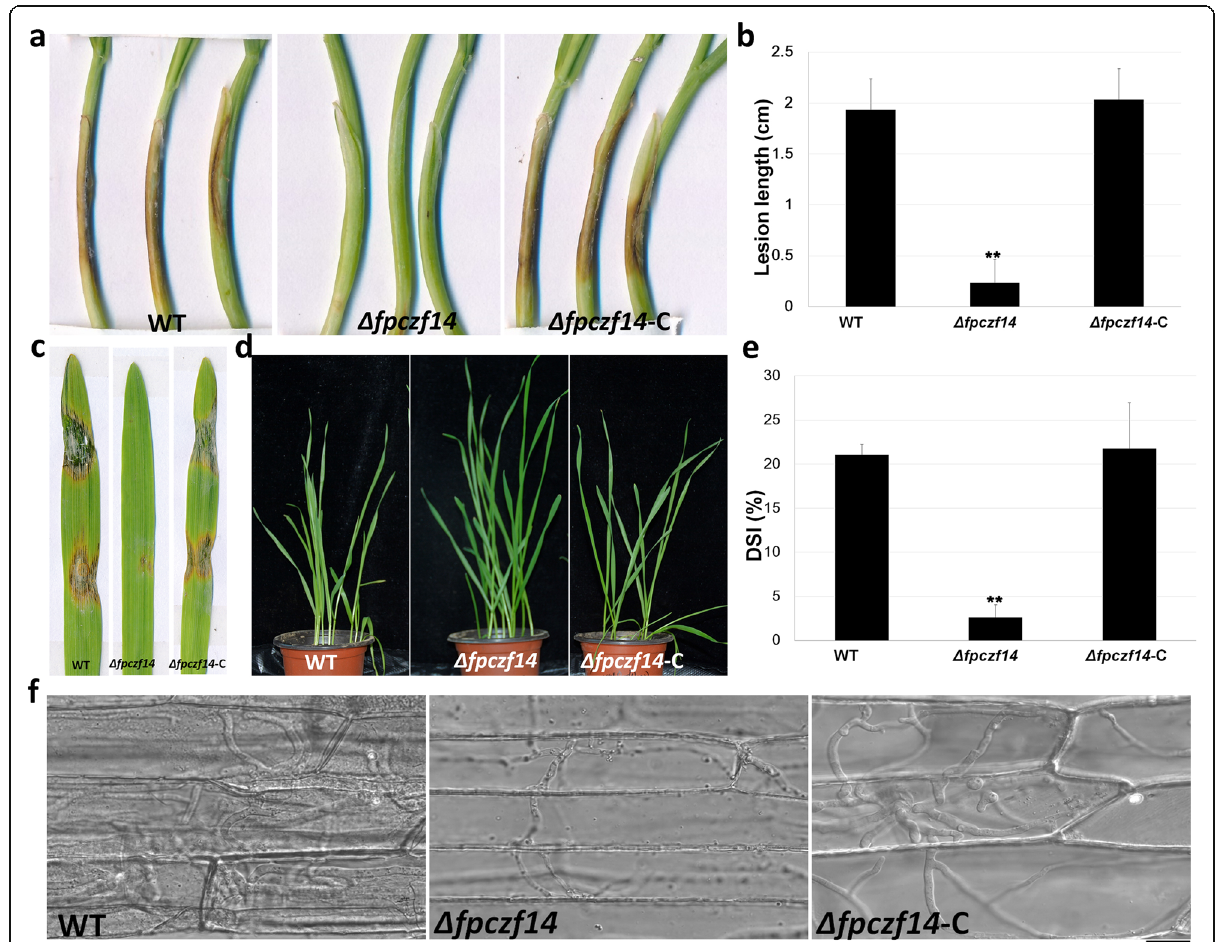
Fig. 5 FpCzf14 contributes to F . pseudograminearum virulence. a Wheat coleoptiles inoculated with mycelial blocks of WT, Δ fpczf14 and Δ fpczf14 -C. b Lesion lengths measured at 3 dpi on five wheat seedlings in each of three independent experiments. The bars indicate the standard deviations (** P <0.01, t -test). c Barley leaves inoculated with mycelial blocks of WT, Δ fpczf14 and Δ fpczf14 -C. d Wheat seedlings inoculated with millet seeds colonized by WT, Δ fpczf14 and Δ fpczf14 -C. e DSI of wheat seedlings from the pot-culture experiment. The data shown are representative of three separate experiments. The bars indicate standard deviations (** P <0.01, t -test). f Microscopic observation of infectious mycelia in wheat coleoptiles at 24 hpi